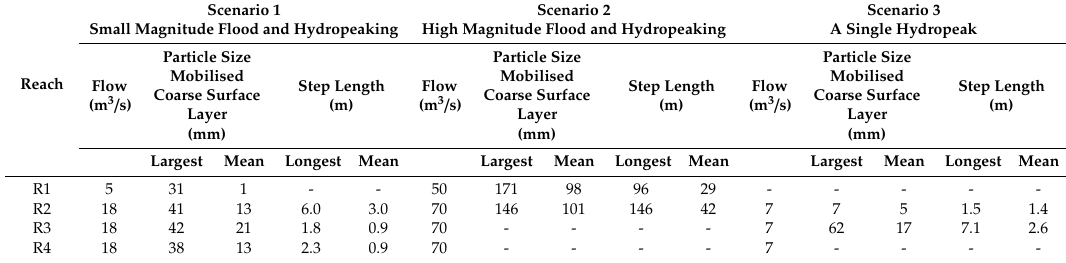
Table 2. Field observations for the di ff erent hydrological scenarios: flow, particles mobilized and step lengths. Note that (i) mobility was measured just in R1 and R2 during scenario 2 (representative of the non-impacted and impacted reaches respectively), and that (ii) no mobility was observed in R4 during scenario